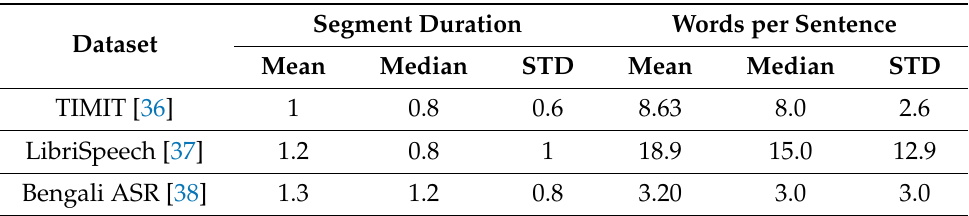
Table 2. The table illustrates the mean, median and deviation of segment duration and words per sentence for each dataset. The segment duration is calculated using the setup described in Section